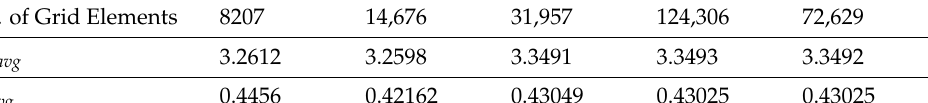
Table 3. Different mesh size for Ha = 0 and ϕ = 0.02.